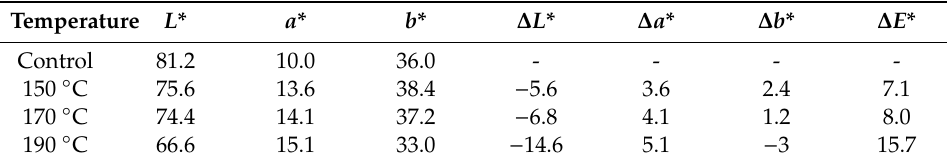
Table 1. Colorimetric analysis of Masson pine wood as a function of temperature. ( L *, a *, b * represent the lightness index, the red-green axis index, and the yellow-blue axis index, repectively; ∆ L * represents